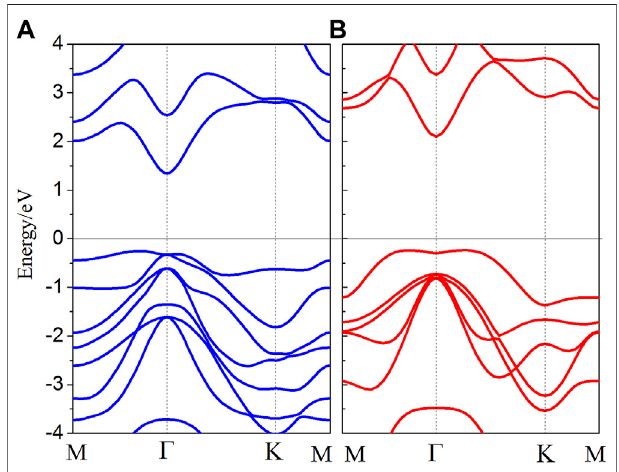
FIGURE 2 | Band structures of monolayers (A) In 2 Se 3 and (B) InSe calculated by the HSE06 hybrid functional.